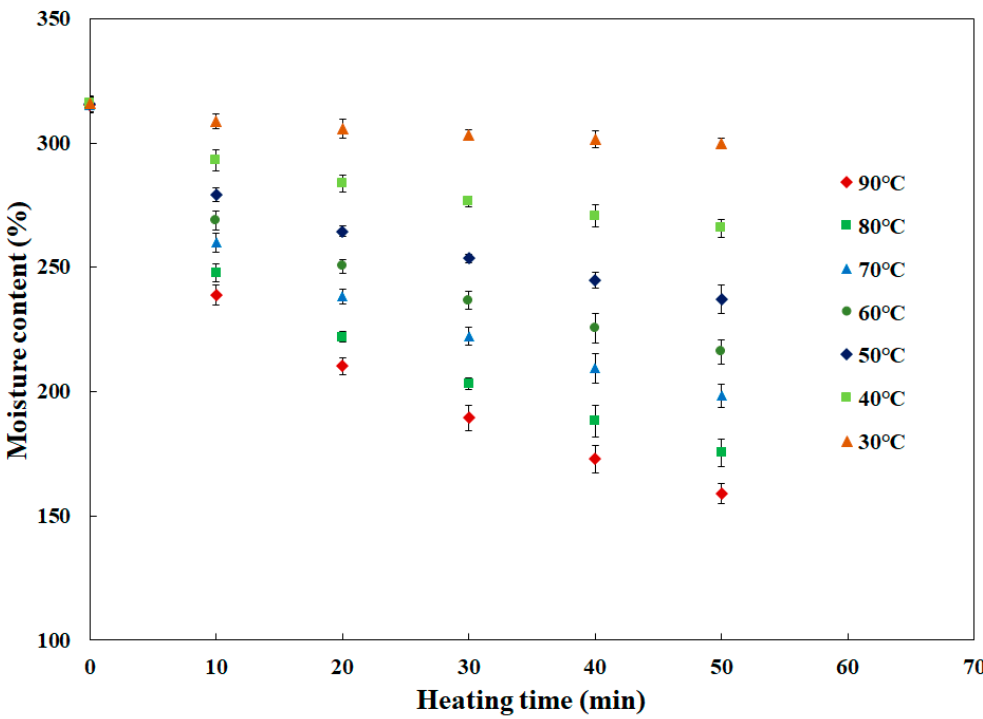
Figure 1. Changes in moisture content of Alaska pollock surimi paste during heating in the dynamic rheometer system under flat-plate geometry.